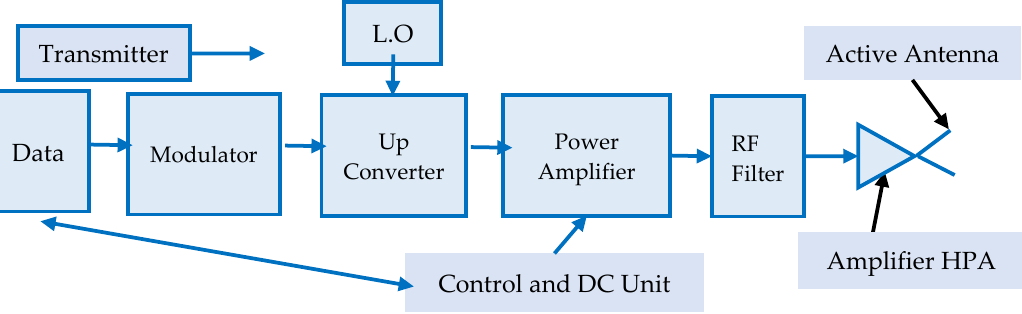
Figure 10: Transmitter block diagram with an integral wearable active transmitting antenna Figure 10. Transmitter block diagram with an integral wearable active transmitting